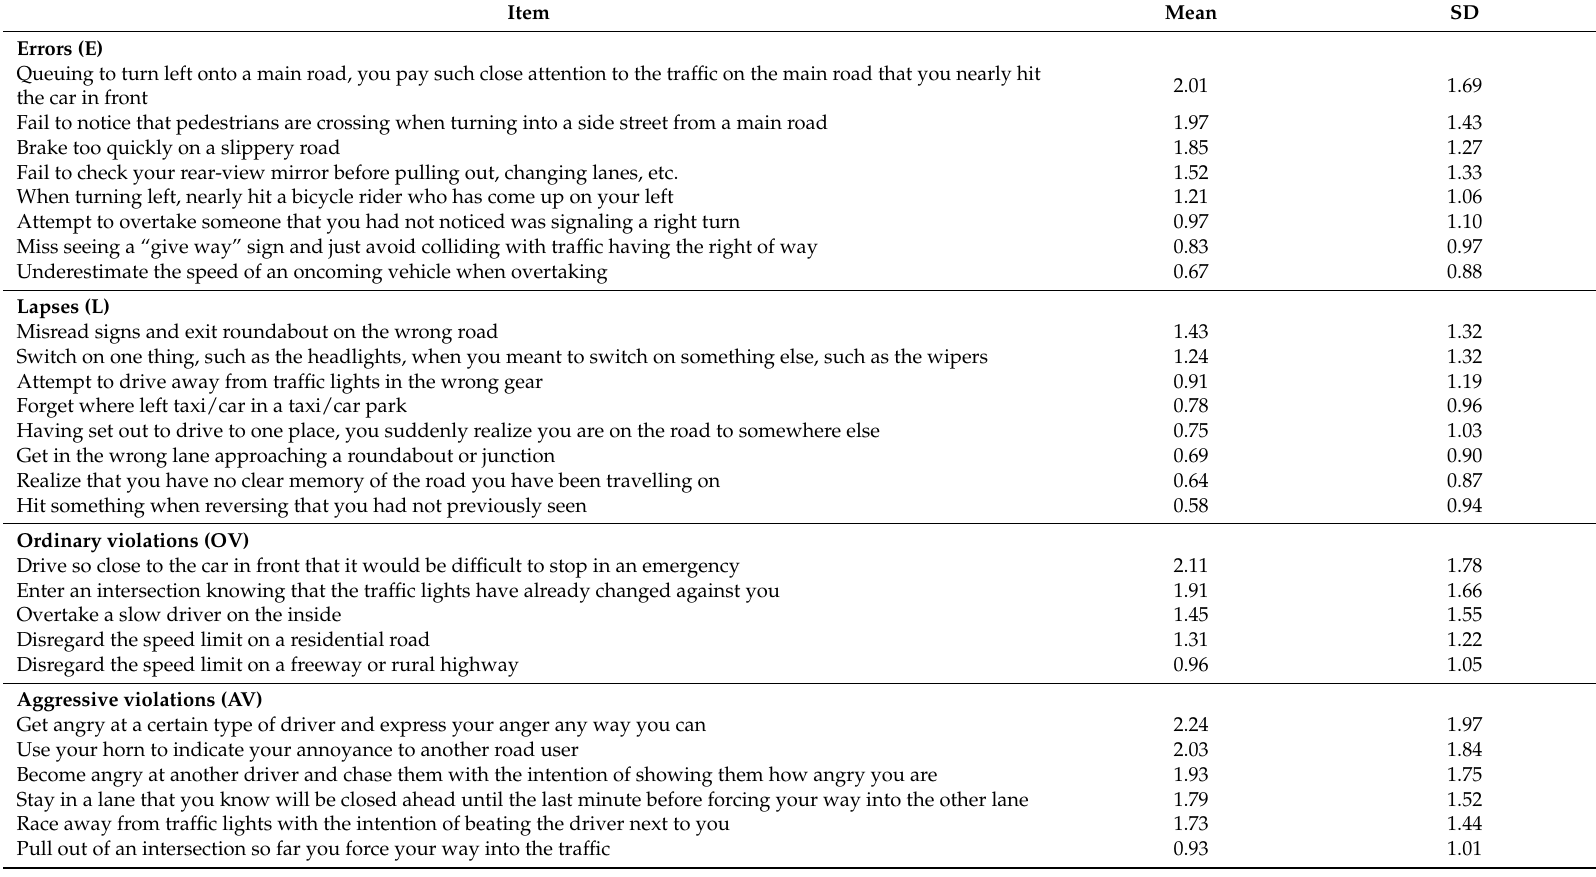
Table 2. Means and standard deviations of all Driver Behaviour Questionnaire (DBQ) items reported by the taxi drivers ( n = 381). Item Mean SD Errors